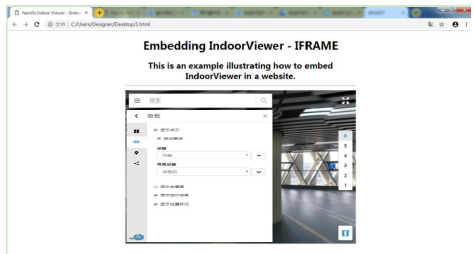
Figure 12. Implementing the effect by invoking API with IFrame